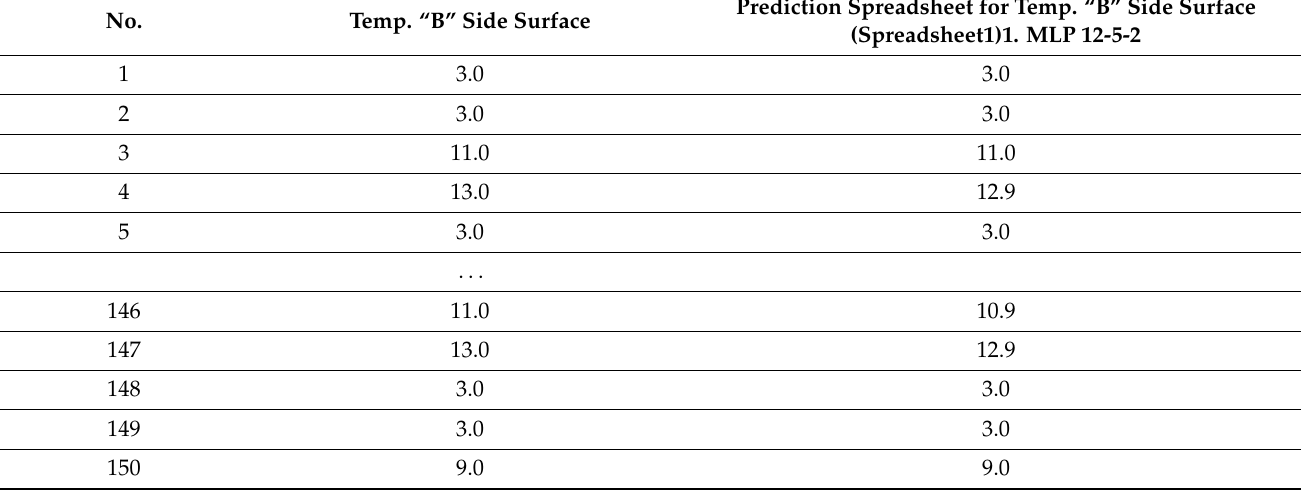
Table 4. Temperature values for